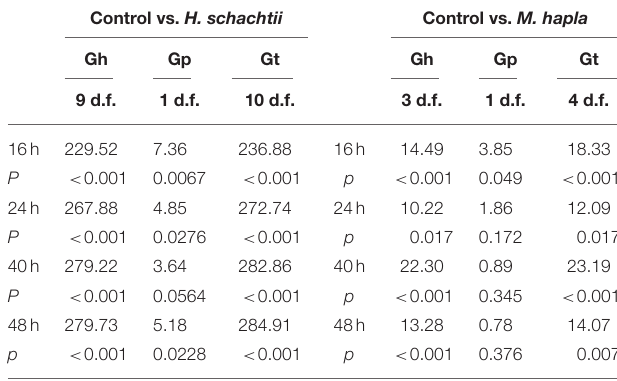
TABLE 4 | G -test test values for the Brevicoryne brassicae choice tests; short term